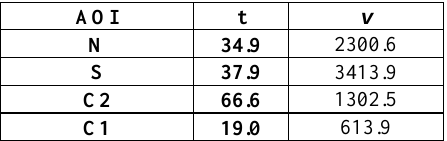
Table 3. Percentage of pixels below the threshold determined Table 2. Student t-test results relative to the average NDVI differences